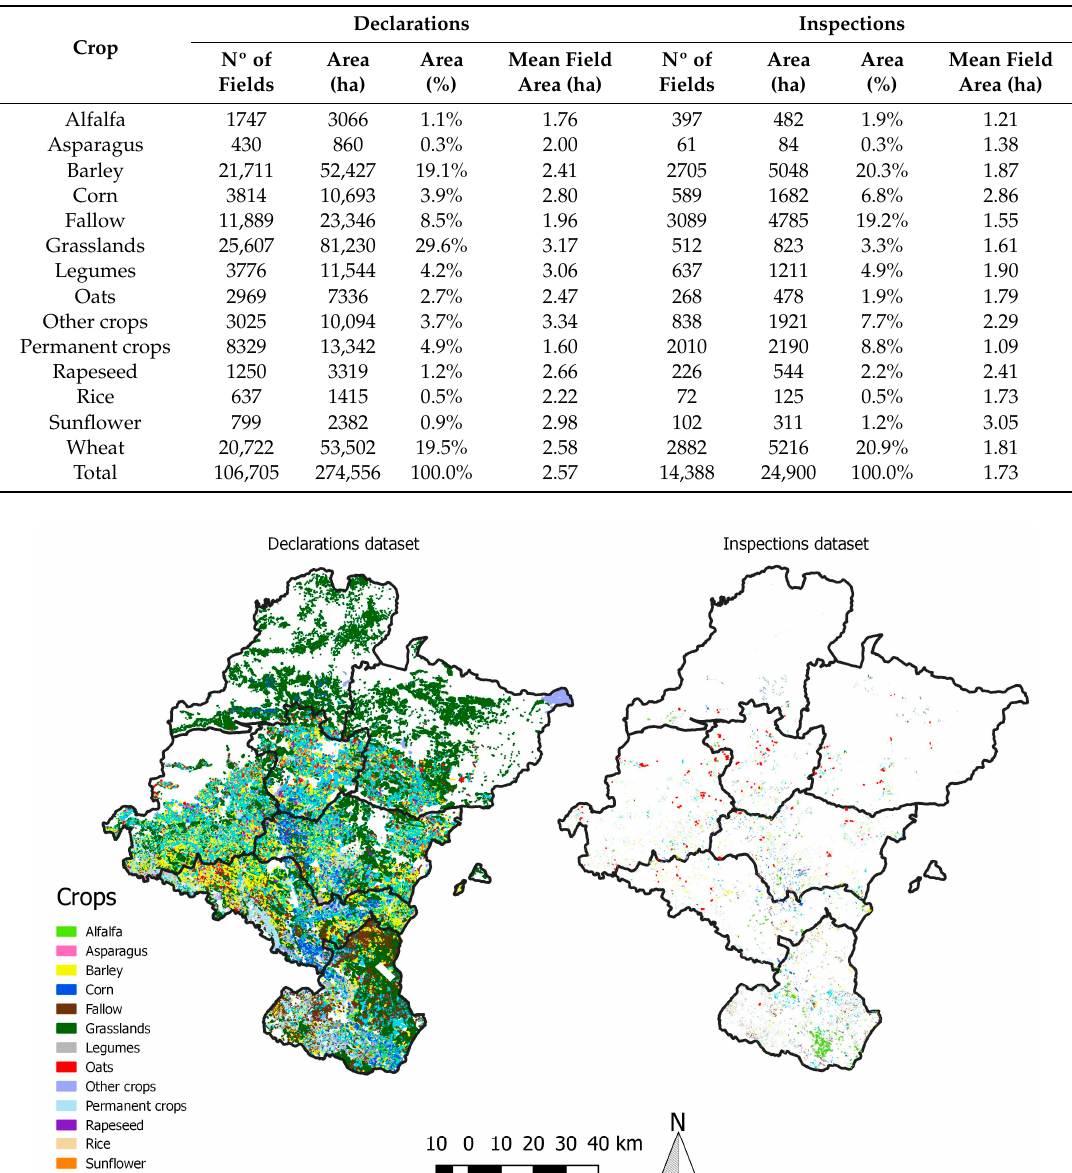
Table 2. Ground truth data. Number of agricultural fields and their area in the declarations and inspections datasets for the whole province of Navarre.